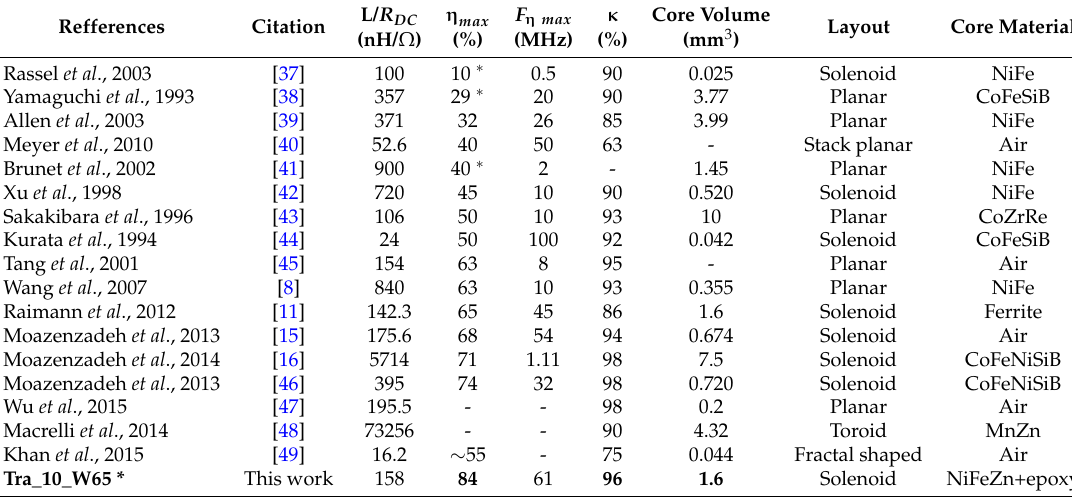
Table 5. Survey on the state of the art microtransformers (pure RF microinductors are excluded). All the devices except the ones which marked with ( ∗ ) were characterized using 50 Ω load.